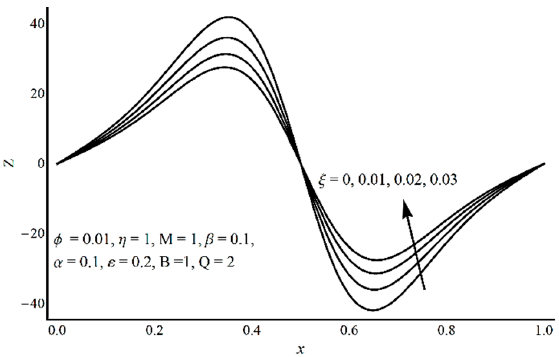
Figure 25. Heat transfer coefficient at the ciliated channel wall for different values of ξ .